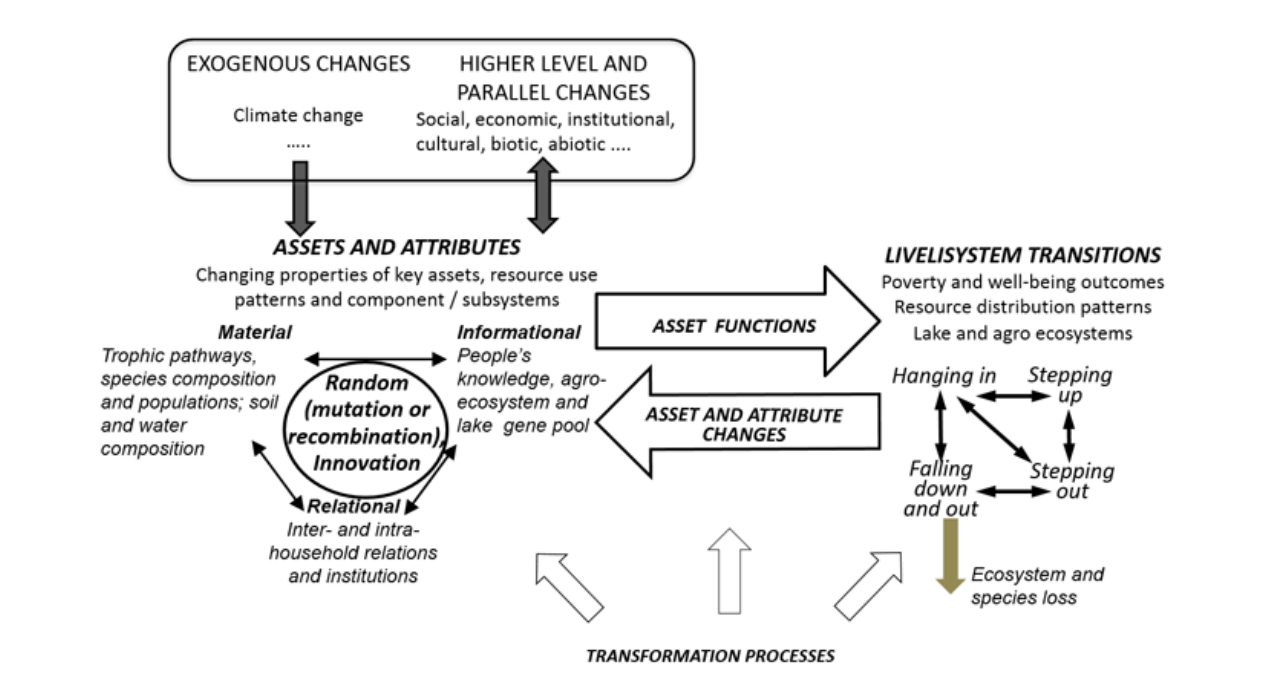
Fig. 3. Generic lake/catchment livelisystems framework,